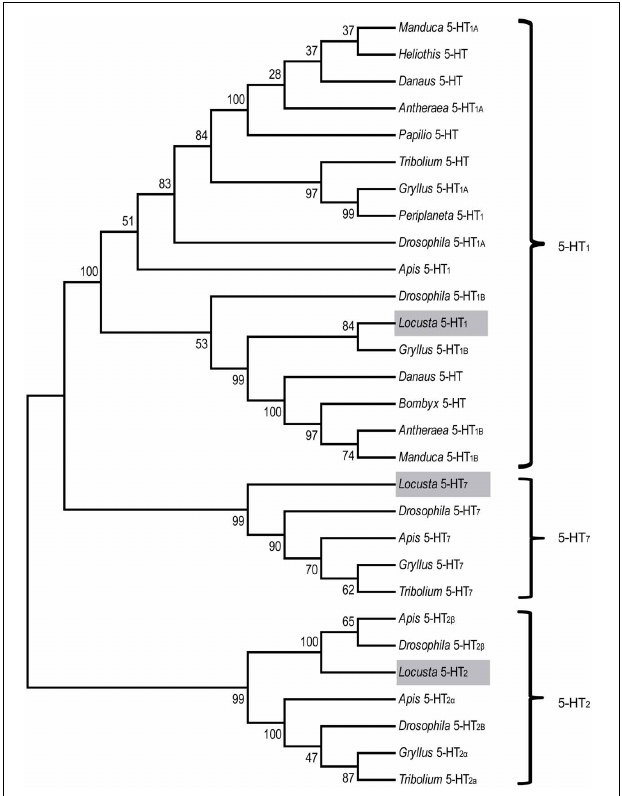
FIGURE 2 | Phylogenetic tree comparing insect serotonin receptors. Phylogenetic and molecular evolutionary analyses were conducted using MEGA 5. The serotonin receptors of the migratory locust ( Locusta 5-HT 1 , 5-HT 2 , and 5-HT 7 ) are indicated by gray bars. Abbreviations: Antheraea, Antheraea pernyi; Apis, Apis mellifera; Danaus, Danaus plexippus; Drosophila, Drosophila melanogaster; Gryllus, Gryllus bimaculatus; Heliothis, Heliothis virescens; Manduca, Manduca sexta; Bombyx,